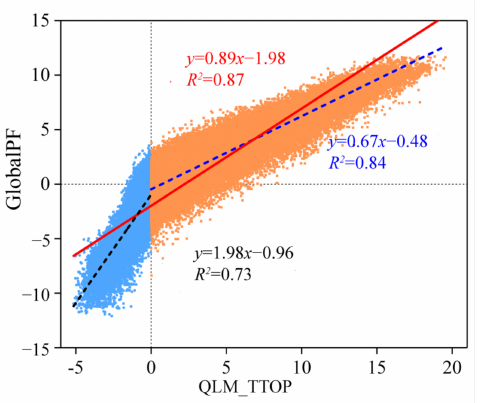
Figure 10. Correlation of the TTOP between GlobalPF [74] and this study